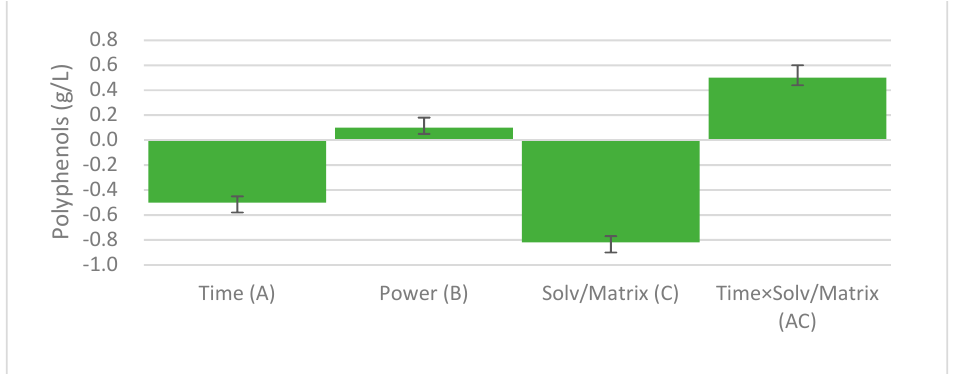
Figure 1. Effects of process variables in microwave-assisted extraction of polyphenols from black- currant waste. A: Time of extraction; B: power of microwave; C: solvent/matrix ratio; AC: power of microwave and time of extraction interaction term. N: number of experiments; R 2 : coefficent of determination; RSD: Residual Standard Deviation; DF: Degrees of Freedom; Q 2 : goodness of prediction; Confidence: confidence interval. N = 12, R 2 = 0.996, RSD = 0.7465, DF = 7, Q 2 = 0.983, Confidence = 0.95.